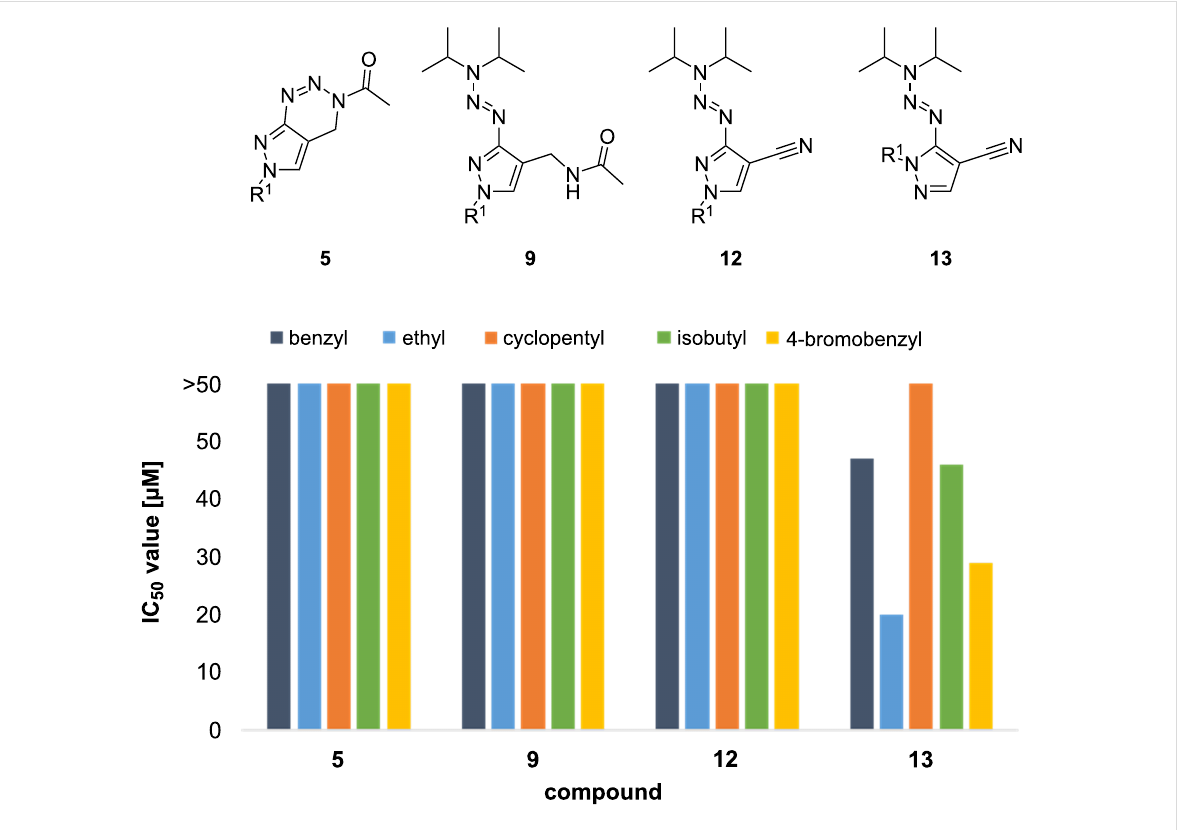
Figure 3: Graphical overview about selected pyrazolo[1,2,3]triazines 5 and intermediates 9 , 12 , and 13 and their calculated IC 50 values after treat- ment of HeLa cells with different concentrations of the respective